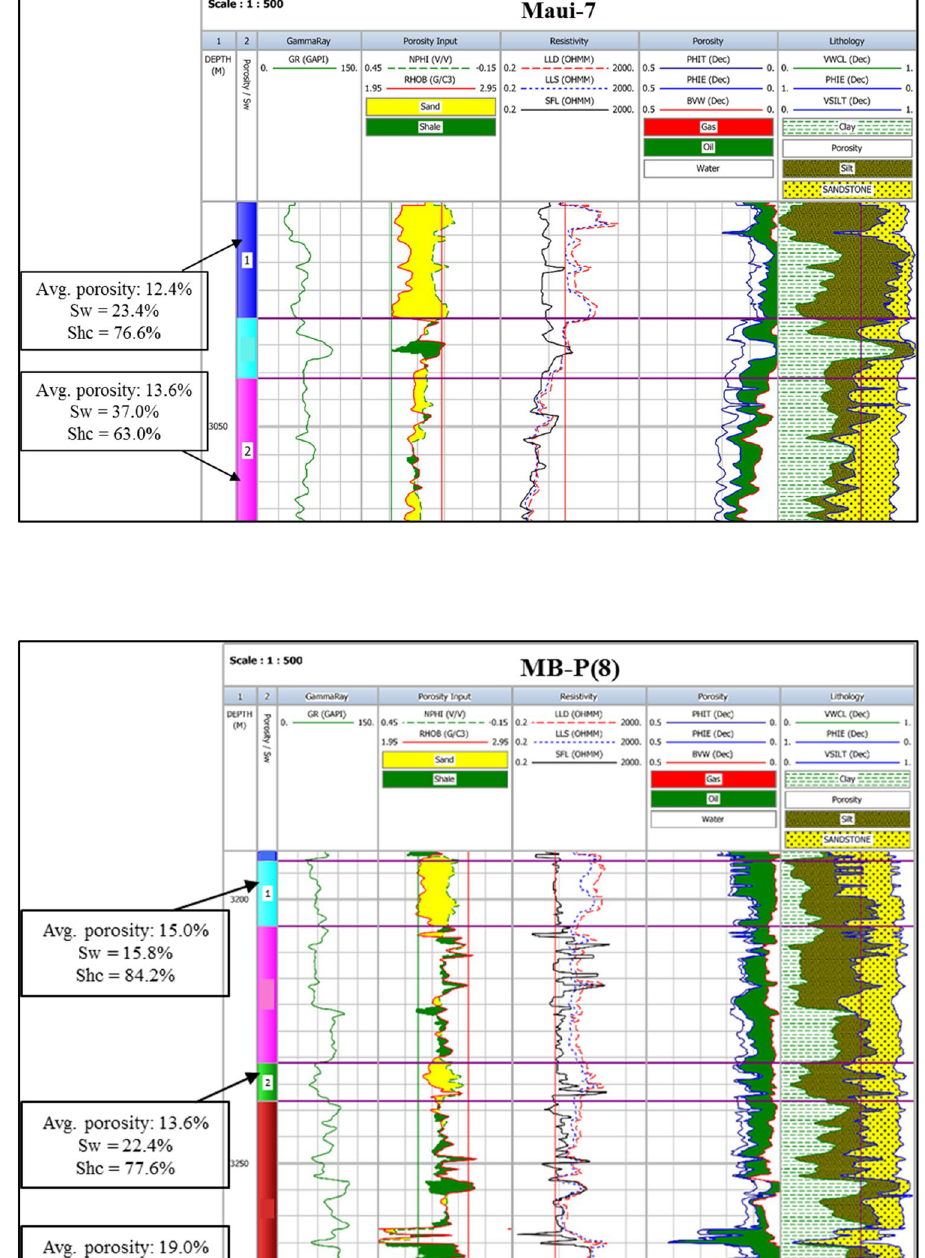
Fig. 14 Well log interpreta- tion of Maui-7, showing two pay zones with good resistivity separation